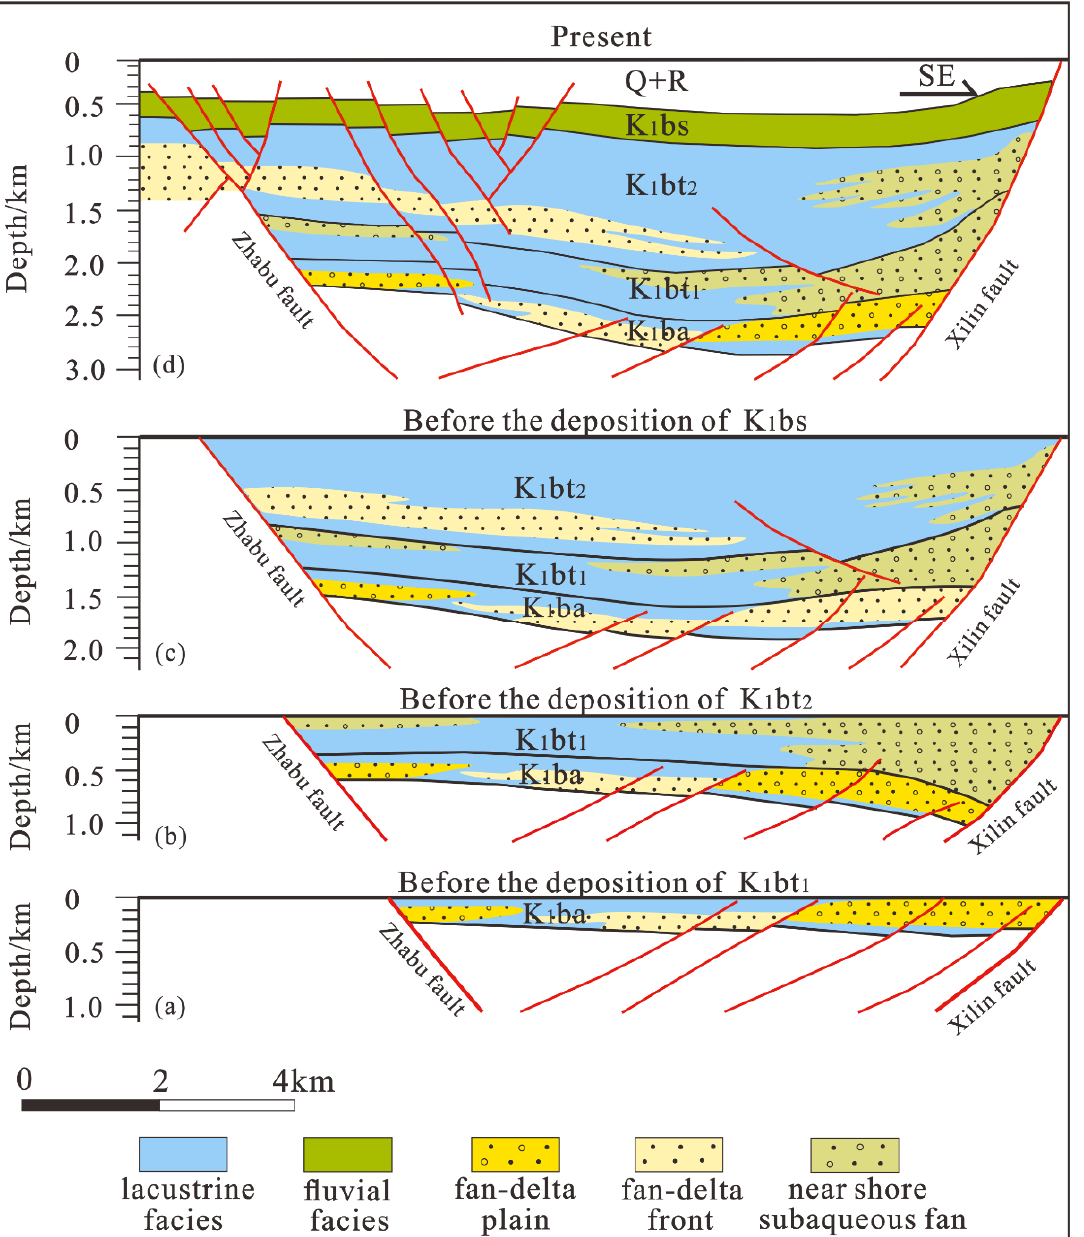
Figure 13. Deposition pattern of the Saidong sub-sag controlled by tectonic faults [62]. ( a ) Deposition pattern of the Saidong sub-sag during the depositing period of K 1 ba. ( b ) Deposition pattern of the Saidong sub-sag during the depositing period of K 1 bt 1 . ( c ) Deposition pattern of the Saidong sub-sag during the depositing period of K 1 bt 2. ( d ) Deposition pattern of the Saidong sub-sag during the depositing period of K 1 bt 1 at present. (The red line represents the faults.)